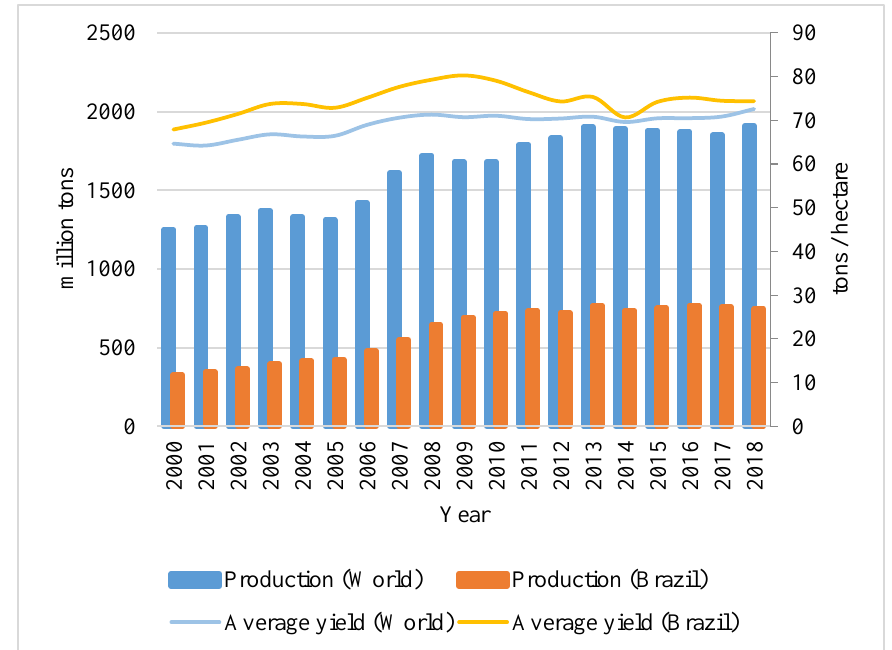
Figure 8. World and Brazilian sugarcane production and yield, 2000–2018. Source: [47,49].